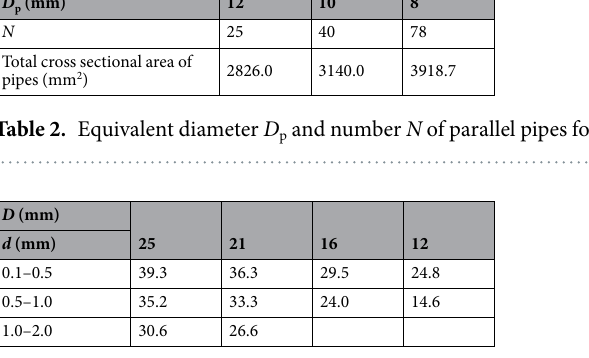
Table 3. Calculated value of D 0 (mm) with different diameters of sand and